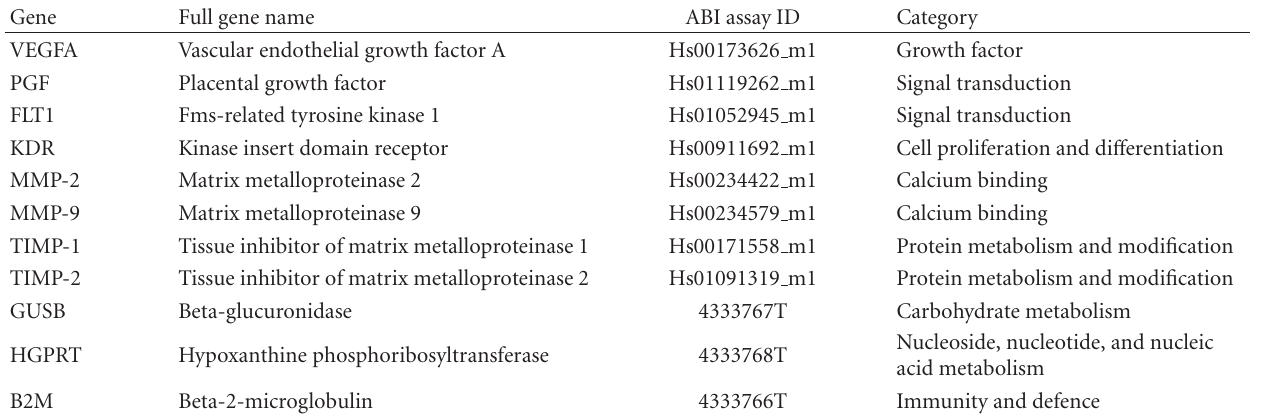
Table 1: Primer information for Real time PCR.